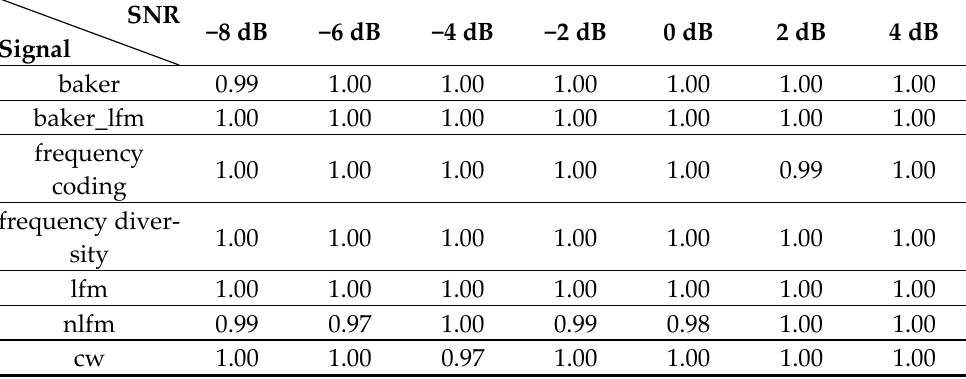
Table A4. Recognition results of one-dimensional DRSN under Cauchy noise.